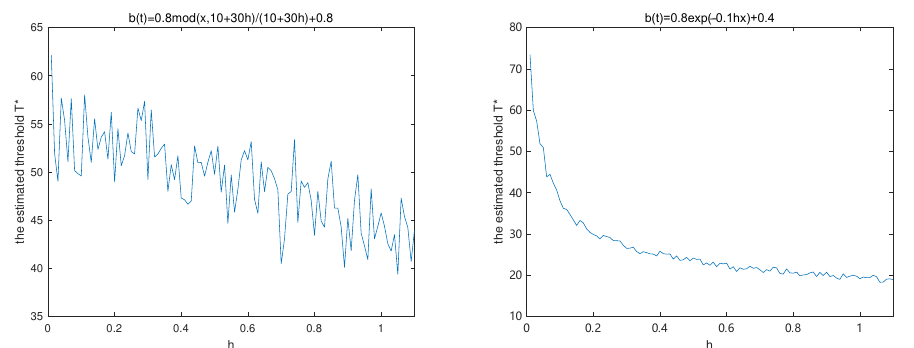
Figure 2. The change of the average estimated threshold T ∗ . ( left ): { b i ( t ) } are periodic functions; ( right ): { b i ( t ) } are monotone decreasing functions.